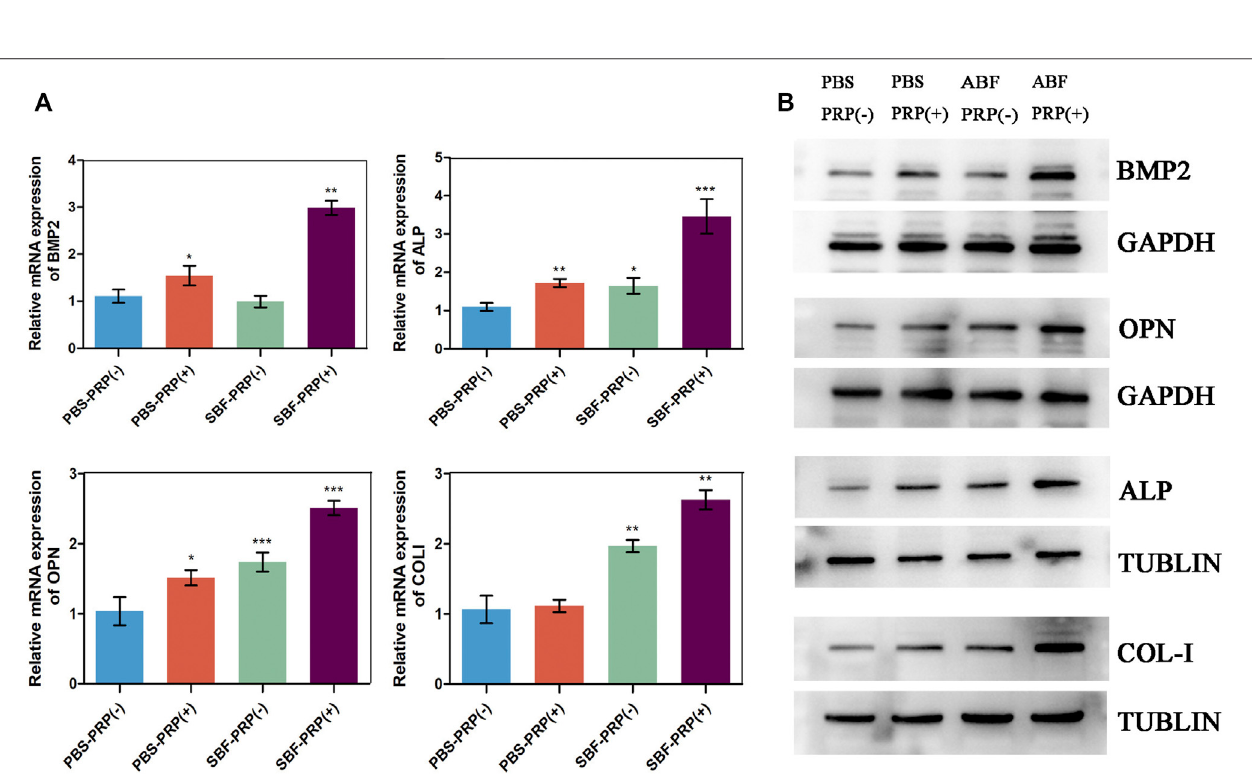
FIGURE 7 | Osteogenic gene and protein expression of BMSCs . (A) RT-PCR analysis of BMP2, OPN, ALP and COLI in BMSCs after 14 days cultivation on PBS- PRP(-),PBS-PRP(+),SBF-PRP(-)andSBF-PRP(+)hydrogels. (B) WesternblotanalysisofBMP2,OPN,ALPandCOLIinBMSCscultivatedonPBS-PRP(-),PBS-PRP (+), SBF-PRP (-) and SBF-PRP (+) hydrogels. * p < 0.05 ** p < 0.01 *** p < 0.001 (Student ’ s t-test). Data are presented as mean ± SD (n ≥ 3).